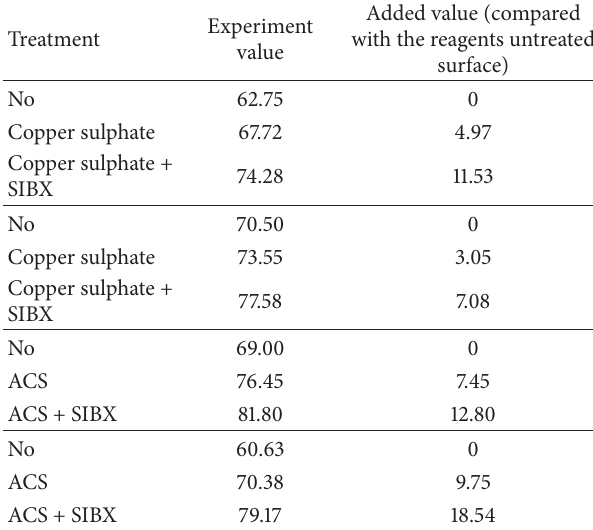
Table 1: Contact angles of the sphalerite with different agents disposed/ ∘